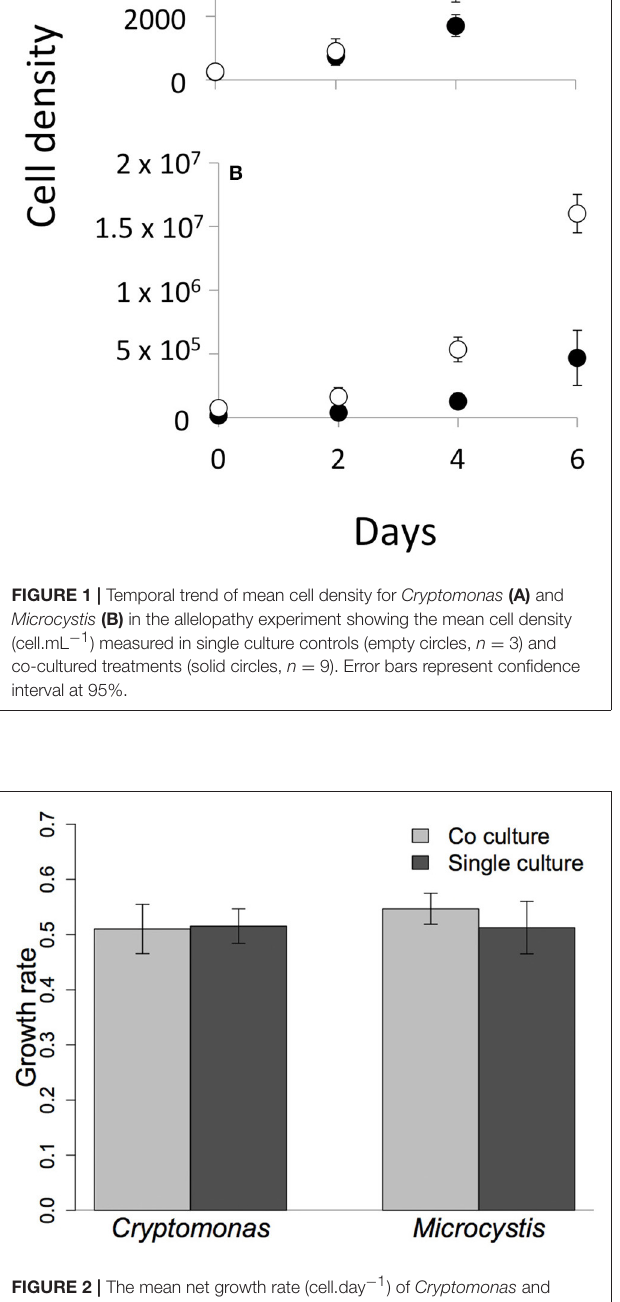
FIGURE 2 | The mean net growth rate (cell.day − 1 ) of Cryptomonas and Microcystis in the 6-day allelopathy experiment compared between the treatment (co-cultures, n = 9) and control (single culture, n = 3). Error bars indicate confidence intervals.